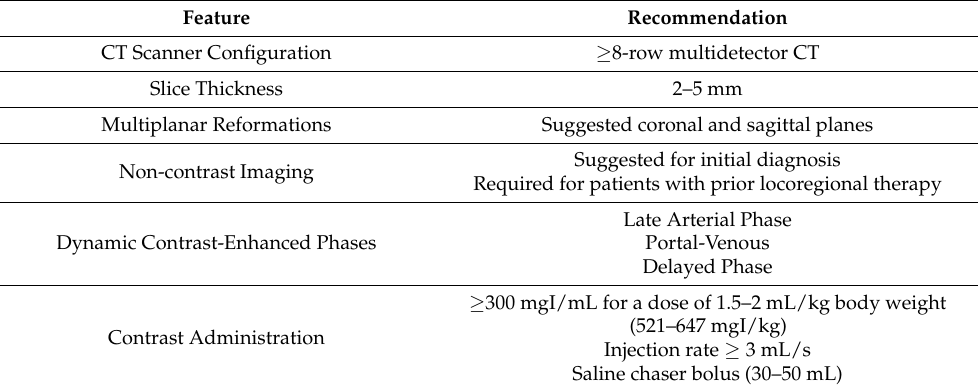
Table 2. Basic technical recommendations for CT